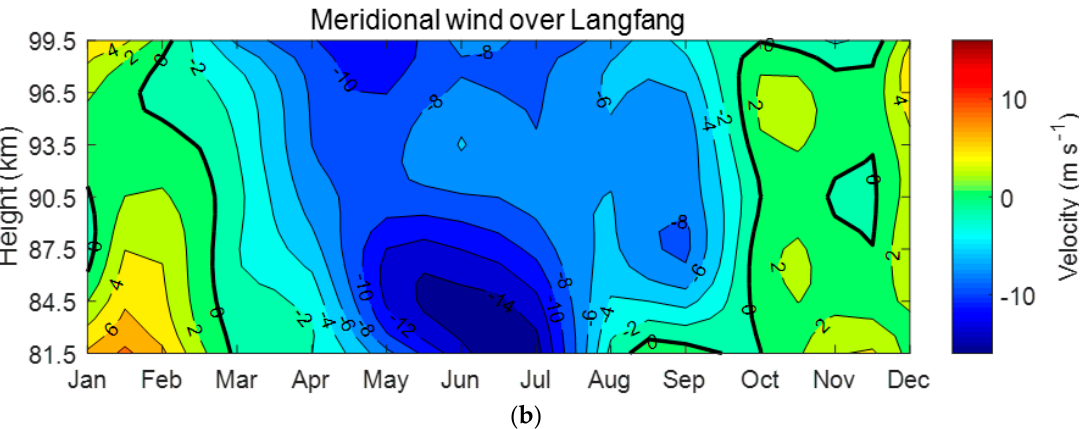
Figure 3. Height-time cross-sections for monthly averaged meridional momentum flux and background wind. Each line in the momentum flux contour plot corresponds to 1 m 2 s − 2 and each contour in the wind plot corresponds to 2 m/s. ( a ) Vertical flux of meridional momentum over LangFang; ( b ) Meridional wind over LangFang.